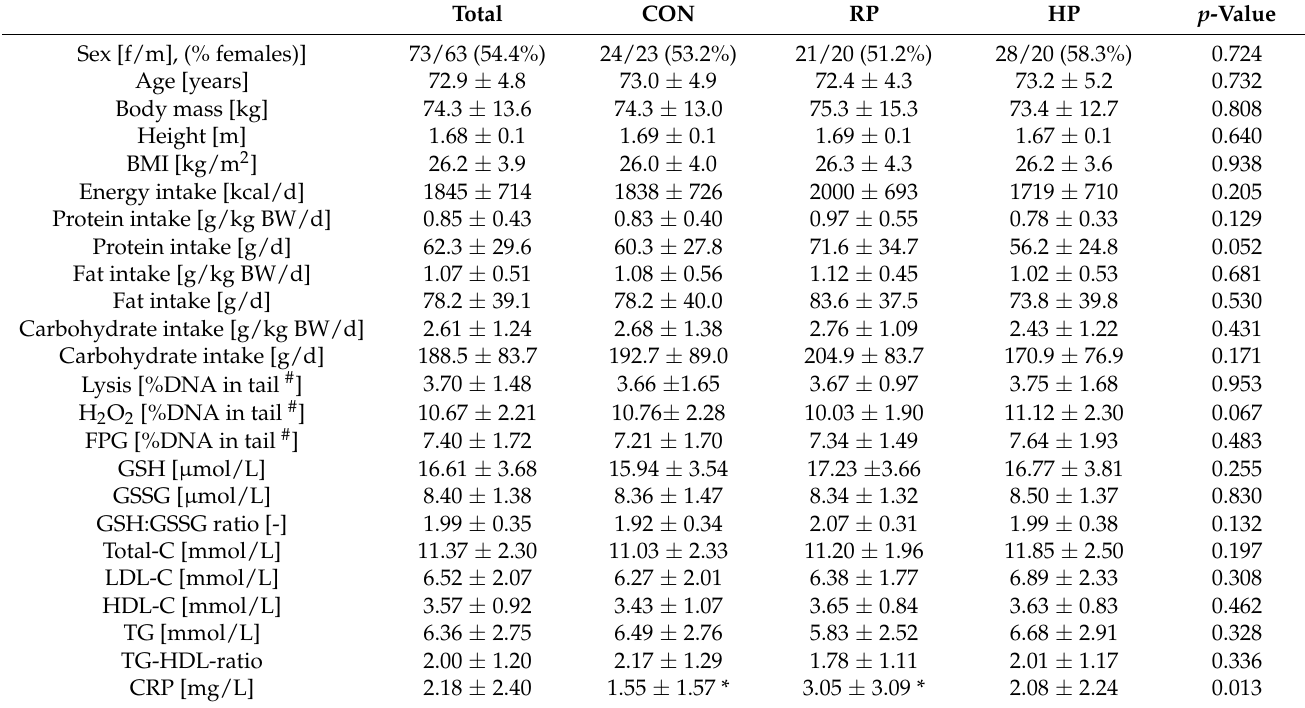
Table 1. Baseline characteristics and nutrient intake of the participants in the Austrian study.